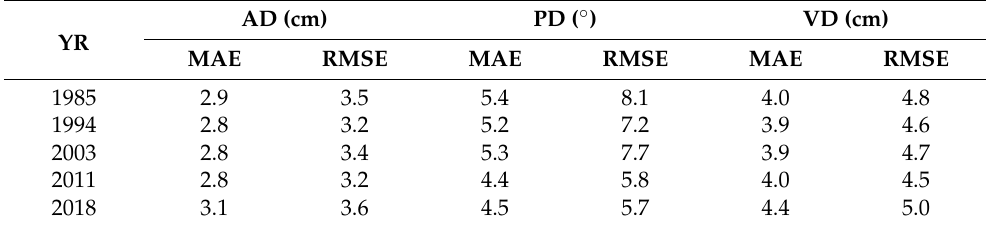
Table 3. The deviations between the simulated results and observations at T/P points in different periods.